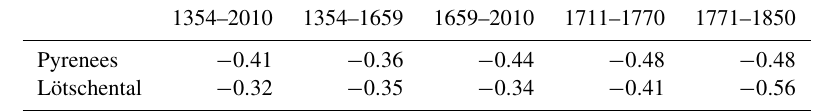
Table 4. Pearson correlation coefficients ( r ) for various sub-periods between wine harvest dates and tree-ring-based temperature reconstruc- tions. All correlations are statistically significant ( p < 0 . 05).